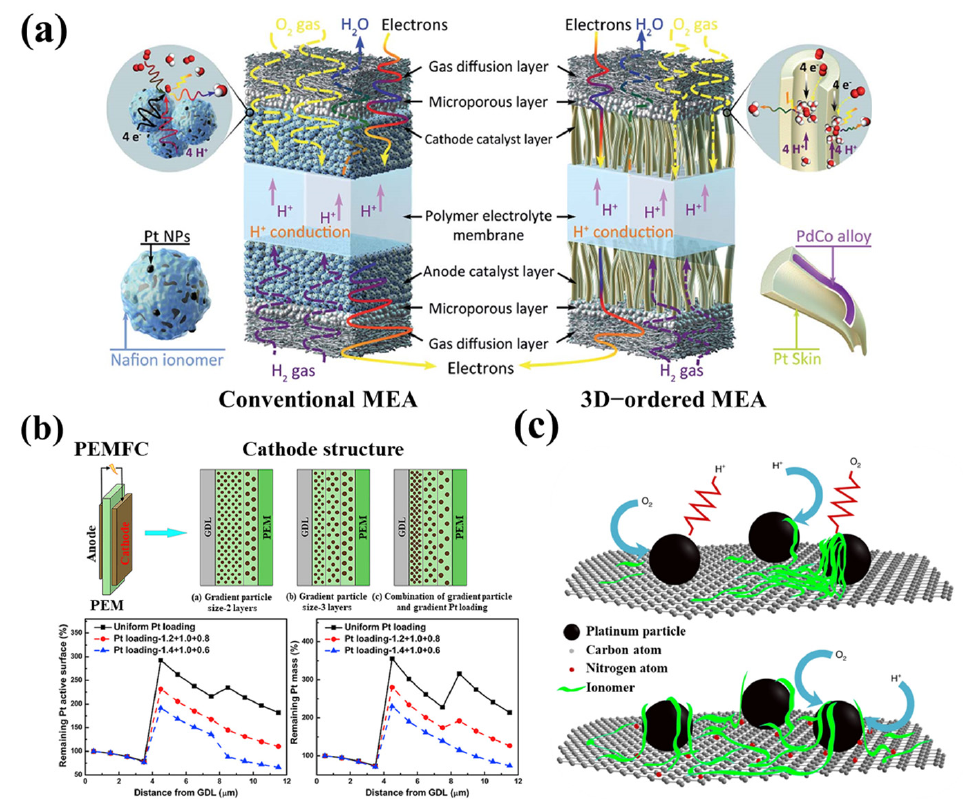
Figure 6. Optimization of CL structure to improve MEA performance: ( a ) Diagram of conventional MEA and ordered MEA. Reprinted with permission from Ref. [107]. Copyright 2018, RSC. ( b ) Design of Gradient CL Structure. Reprinted with permission from Ref. [114]. Copyright 2020, Elsevier. ( c ) Modified supports to regulate the distribution of ionomers. Reprinted with permission from Ref. [115]. Copyright 2020, Springer Nature.